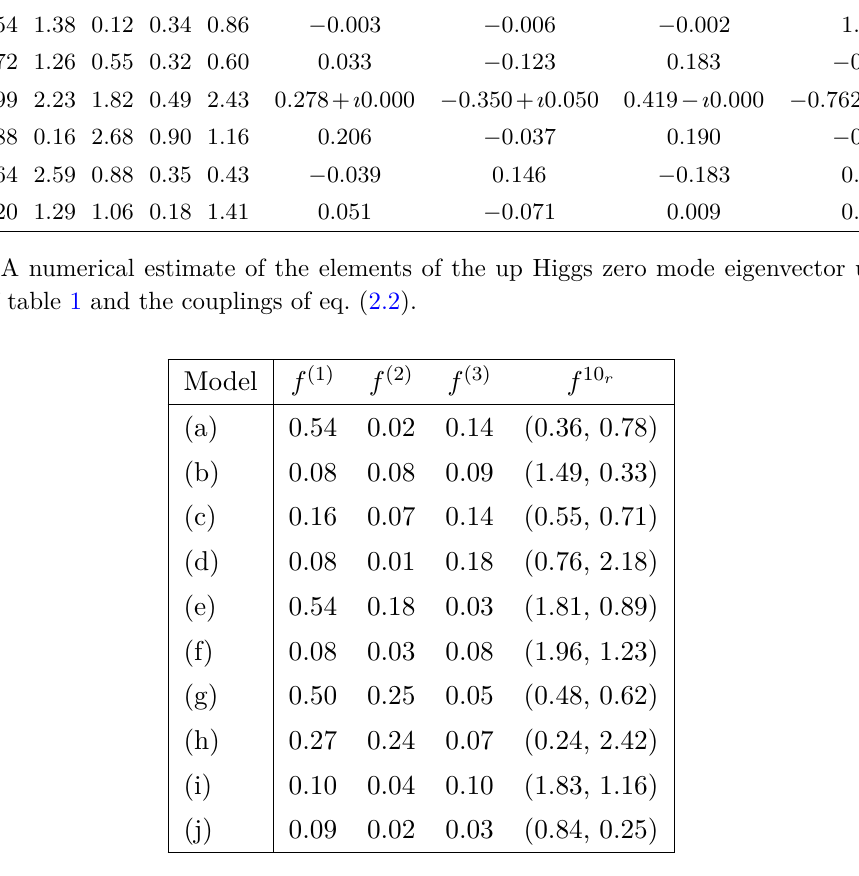
Table 4 . The GUT scale parameters in the cubic and quartic superpotentials W 3 , W (1) W (3)